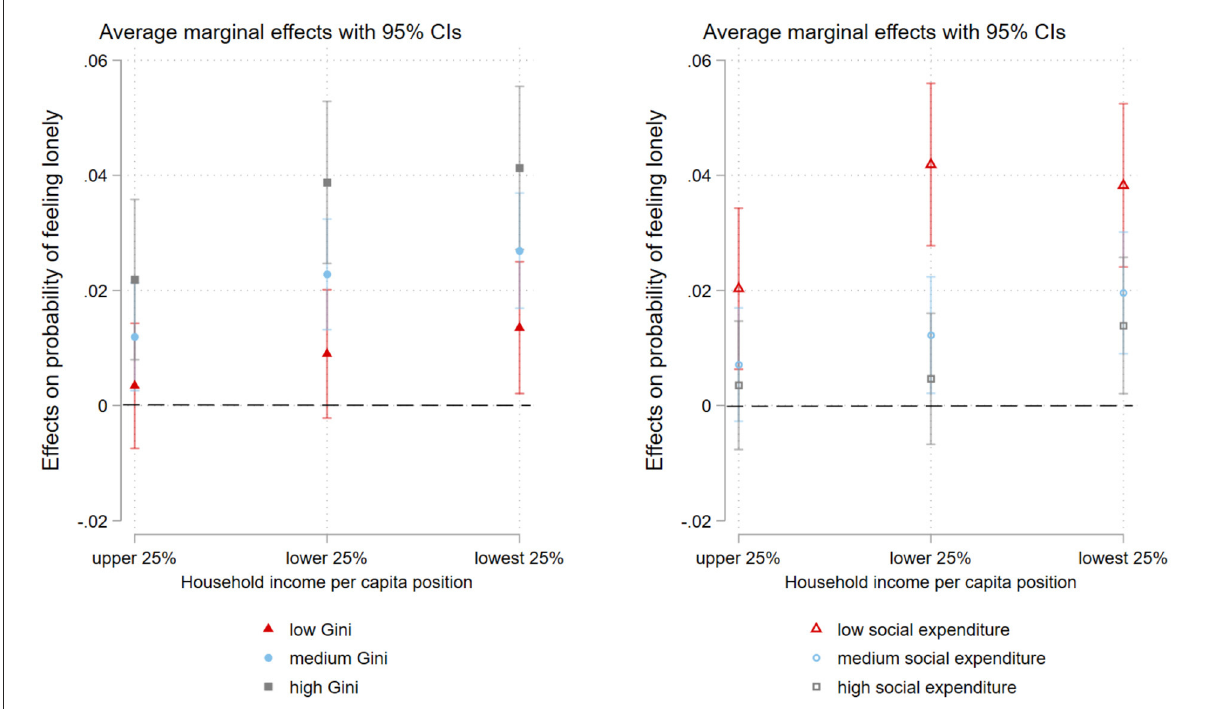
FIGURE2 Average marginal effects of individual-level household income status (compared to the highest 25%) on probability of feeling lonely in different macro